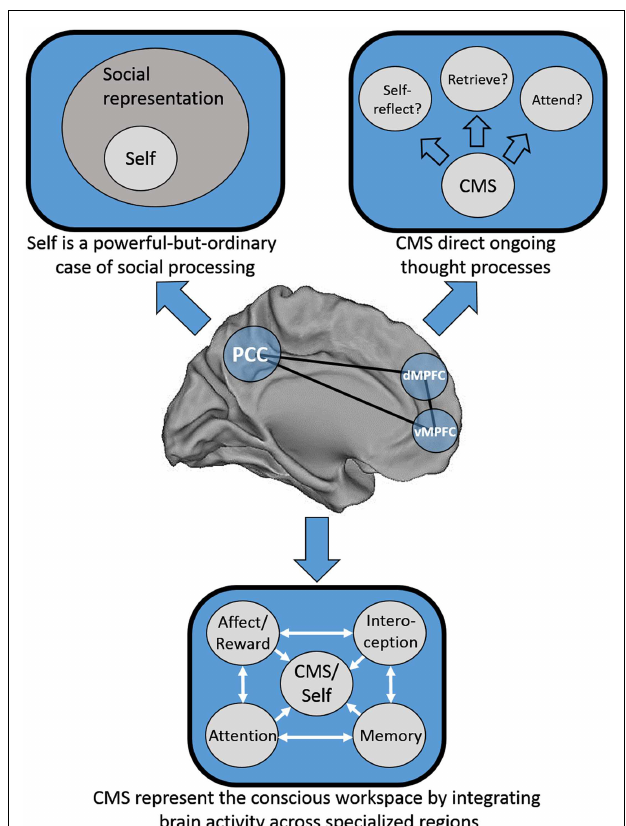
FIGURE 1 | Schematic representation of three possible distinct, but not mutually exclusive models of cortical midline structure (CMS) function .Top left: the CMS are specialized for representing social information, of which the self is a powerful-but-ordinary subset.Top right: the CMS serve as a set of regions responsible for the direction of our thought processes on a moment-to-moment basis. Bottom: the CMS serve as a hub integrating information from disparate neural processing systems into a “conscious